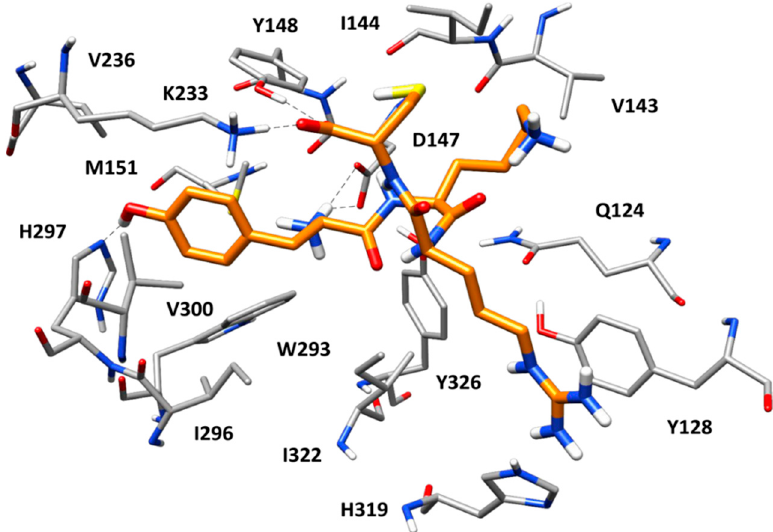
Figure 6. Minimized average structure of peptide 1 (orange) in complex with MOR obtained from the molecular dynamics (MD) simulation. The main ligand-protein H-bond interactions are shown as black dashed lines.